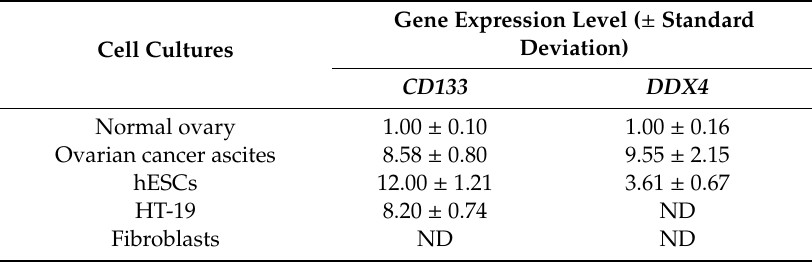
Table 2. Preliminary qPCR analysis of the expression of the CD133 and DDX4 genes in cell cultures from normal ovaries, ascites of recurrent ovarian cancer and human embryonic stem cells (hESCs) after sorting, and the colon cancer cell line HT-29 (positive control) and human adult dermal fibroblasts (negative control). Gene expression was normalised relative to a normal ovary. Because of the small number of samples, the statistical analysis was not performed. A more than two-fold change in gene expression compared to the normal ovary sample was considered up- or down-regulation of a specific gene. Legend : ND-not detected; gene was not